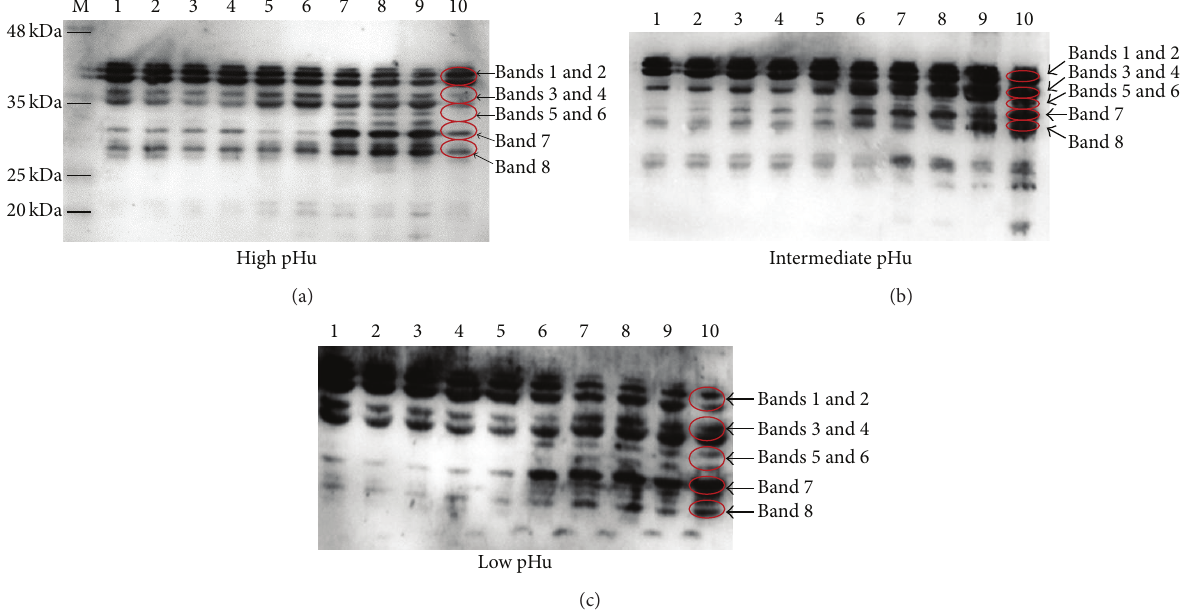
Figure4:RepresentativeWesternblotoftroponin-Tanddegradationproducts.Eachlanewasloadedwith40 𝜇 gofprotein.Misthemolecular weight marker. Lanes 1 to 10 represent the variability in troponin-T degradation from high, intermediate, and low pHu beef aged at 4 ∘ C for 0.5 h, 3 h, 6h, 12 h, 24 h, 2d, 3 d, 5 d, 7 d, and 9 d postmortem. Bands 1 and 2 = 42 and 40 kDa, Bands 3 and 4 = 38 and 36 kDa, Bands 5 and 6 = 34 and 32 kDa, Band 7 = 30 kDa, and Band 8 = 28